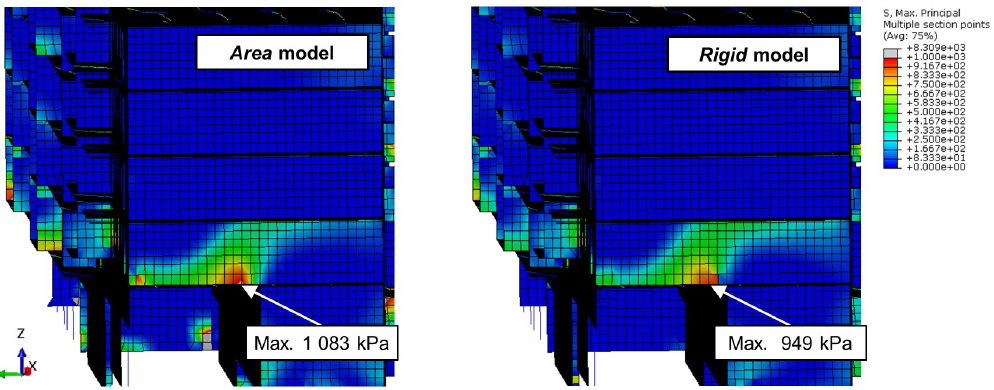
Figure 23. A comparison of the maximum principal stress maps [kPa] in a selected reinforced con- crete deep beam of segment A in the AREA and RIGID models.